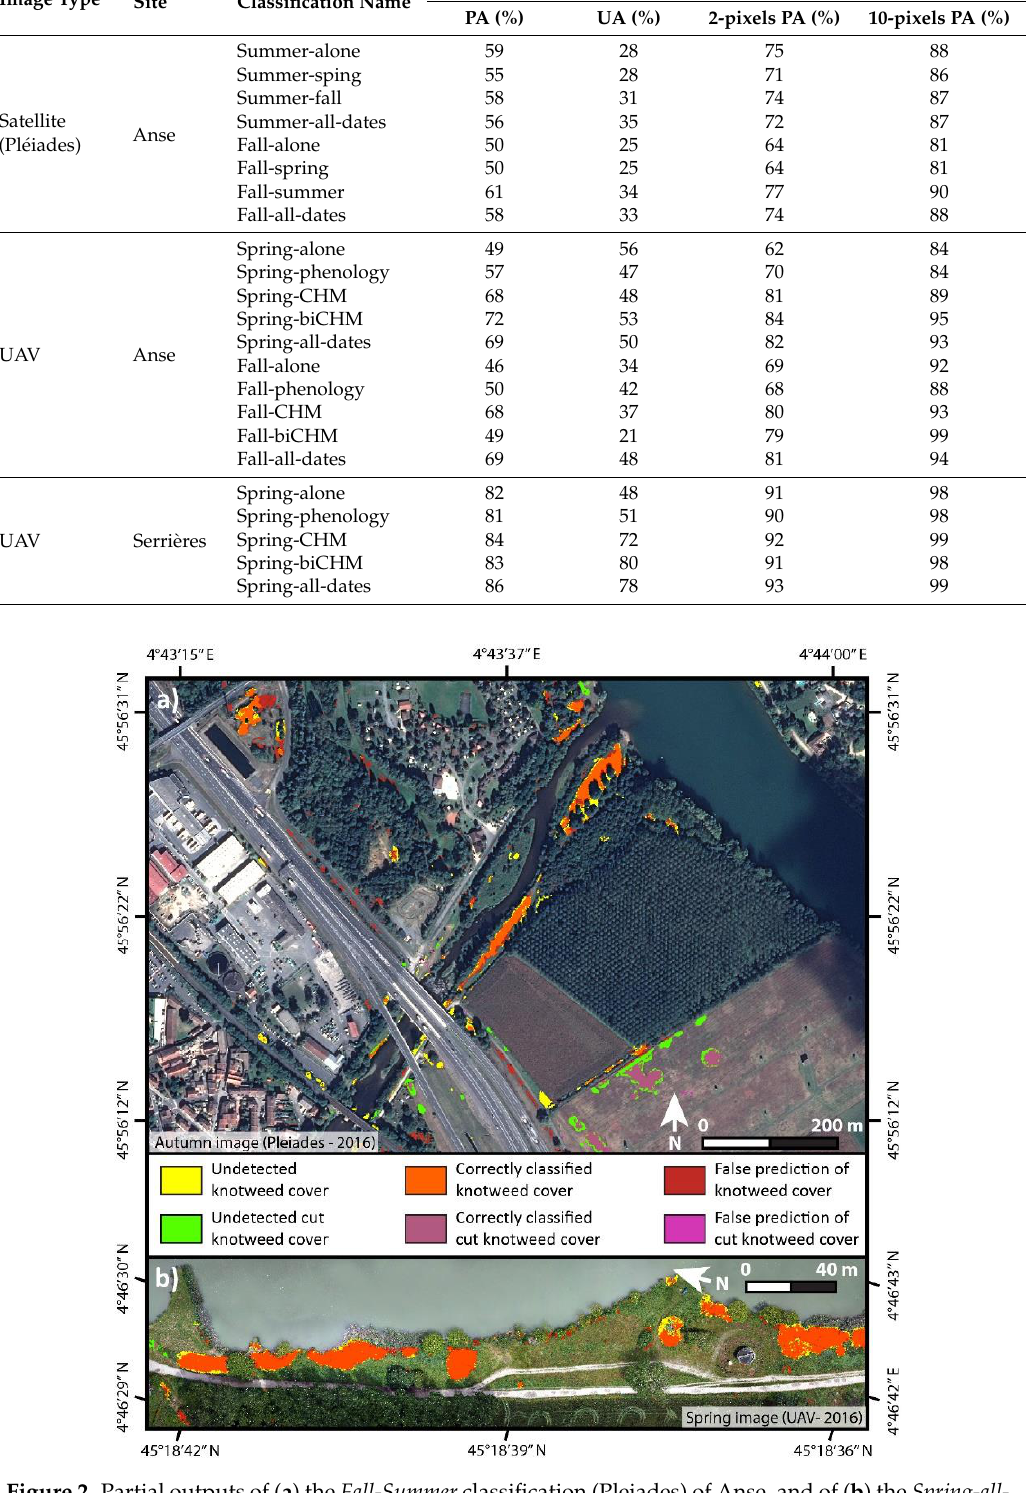
Figure 2. Partial outputs of ( a ) the Fall-Summer classification (Pleiades) of Anse, and of ( b ) the Spring-all-dates classification (UAV) of Serrières. For details on the characteristics of each classification, see Table 2.